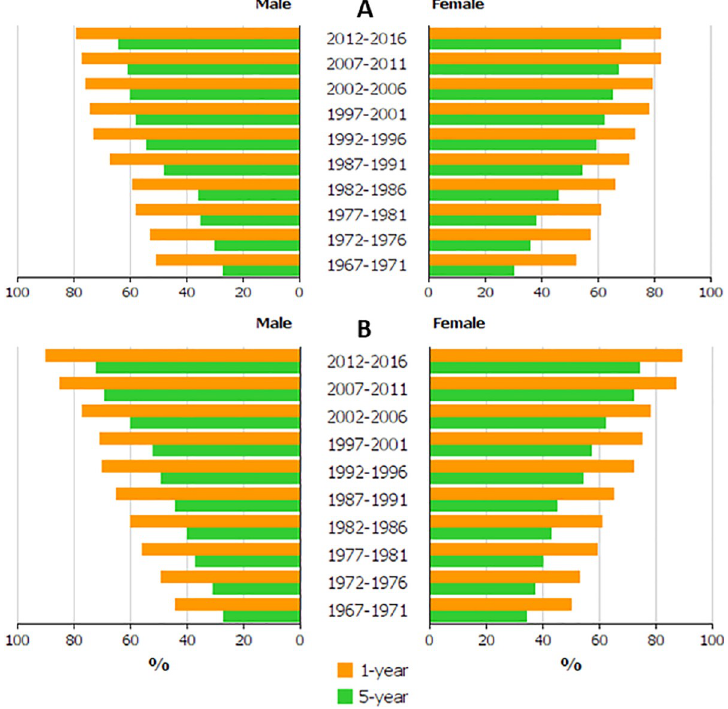
Fig 1. Relative 1-year (yellow bars) and 5-year (green bars) survival in RCC among Finnish (A) and Swedish (B) men and women.